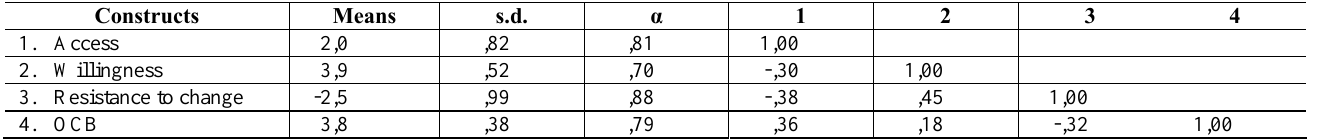
Table 1: Means, Standard Deviations, Cronbach’s alphas and Correlations Constructs